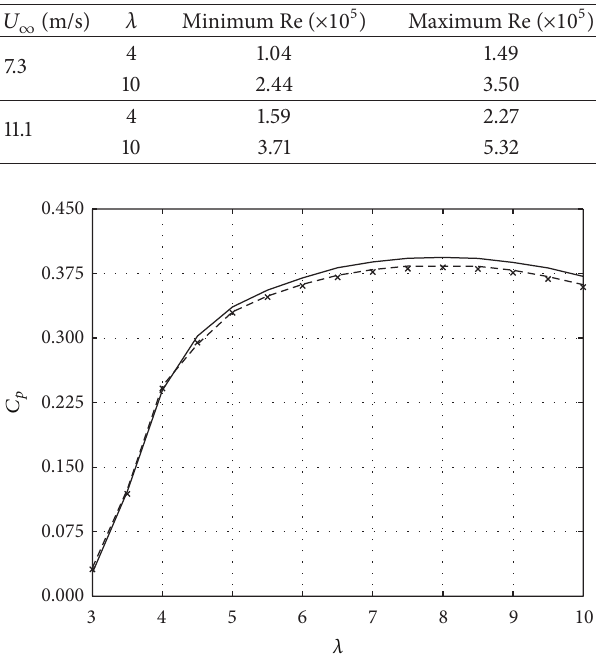
Figure 6: 𝐶 𝑝 versus 𝜆 for 𝑛 = 6 (solid line), 10 (dashed line), and 14 (cross marker) blade elements. Model input: 𝑈 ∞ = 11 m/s, 𝑁 crit = 7 , AERODAS, tip loss model